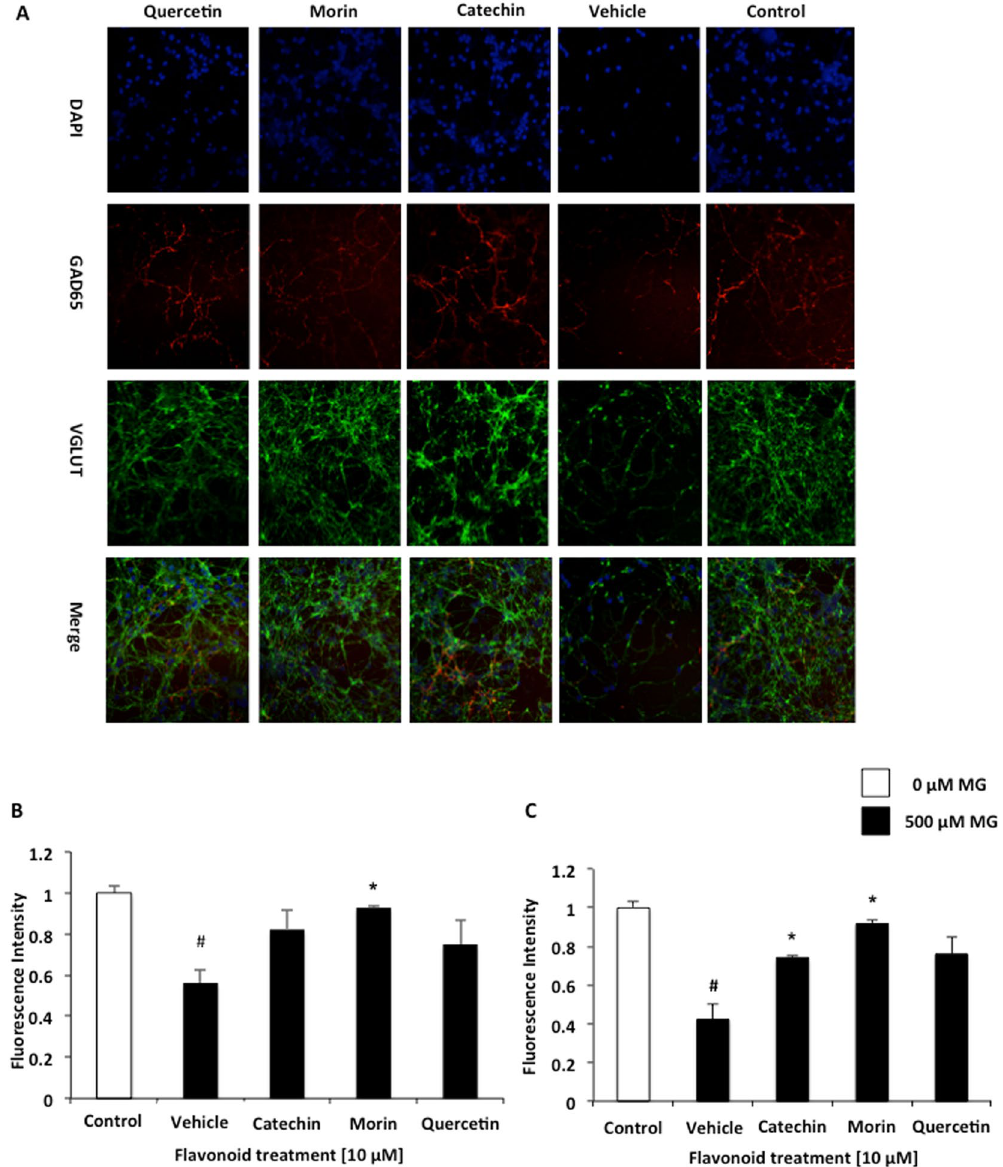
Figure 4. Effects of flavonoid treatment on excitatory and inhibitory synaptic functions. Functions were assessed through immunocytochemistry. Representative images showing DAPI, VGLUT1, and GAD65 in flavonoid (10 µ M) and MG (500 μ M) treated cerebellar neurons ( A ). Excitatory and inhibitory synapse function was assessed through detection of VGLUT1 ( B ) and GAD65 ( C ). Control = no MG, Vehicle = only MG. Values are means + / − SEM of samples performed in triplicate from several independent experiments, n = 3–4. # P < 0.05 (vs Control), * P < 0.05 (vs